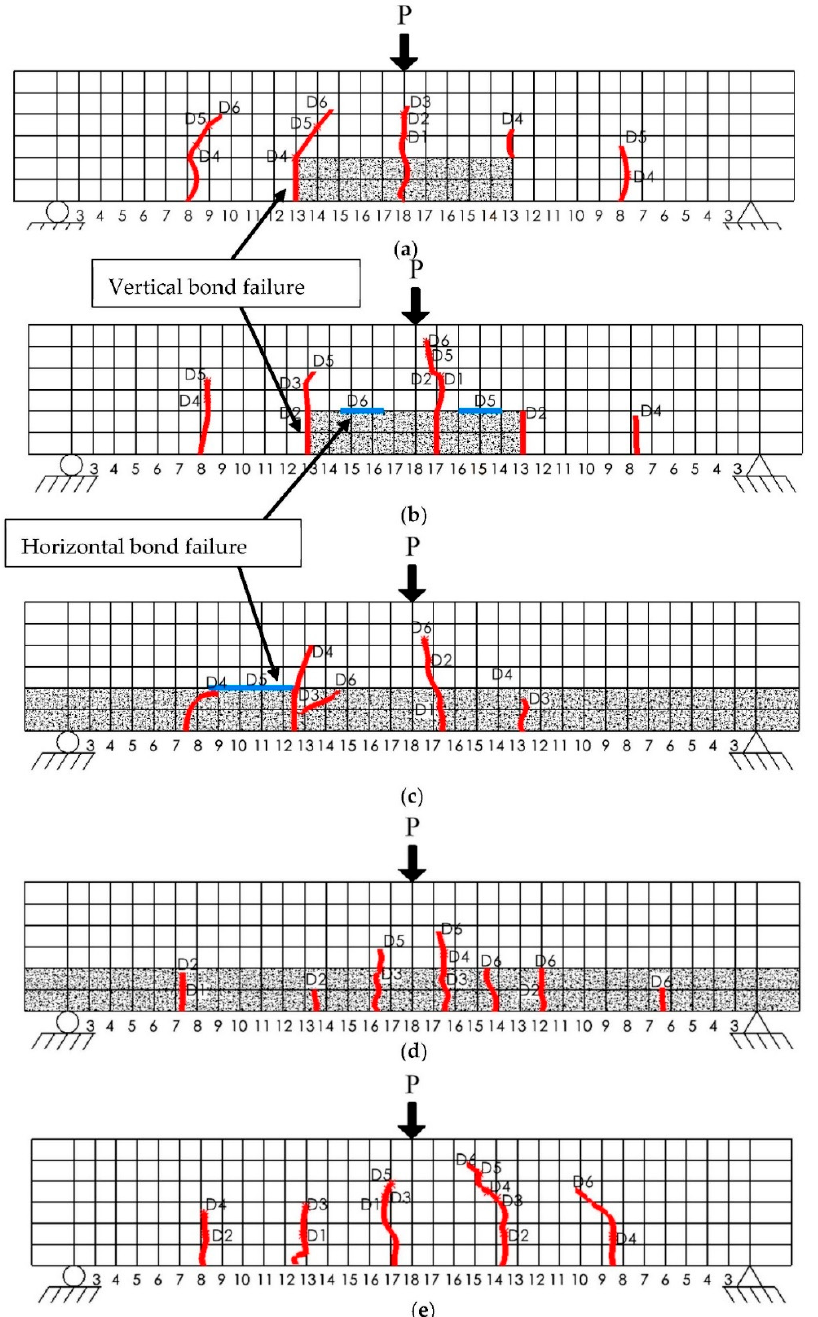
Figure 5. Crack pattern of beams with ( a ) 1/3-span repaired with Mix M ( b ) 1/3-span repaired with Mix F ( c ) full-length repair with Mix F ( d ) full-length repair with Mix M ( e ) no repair.